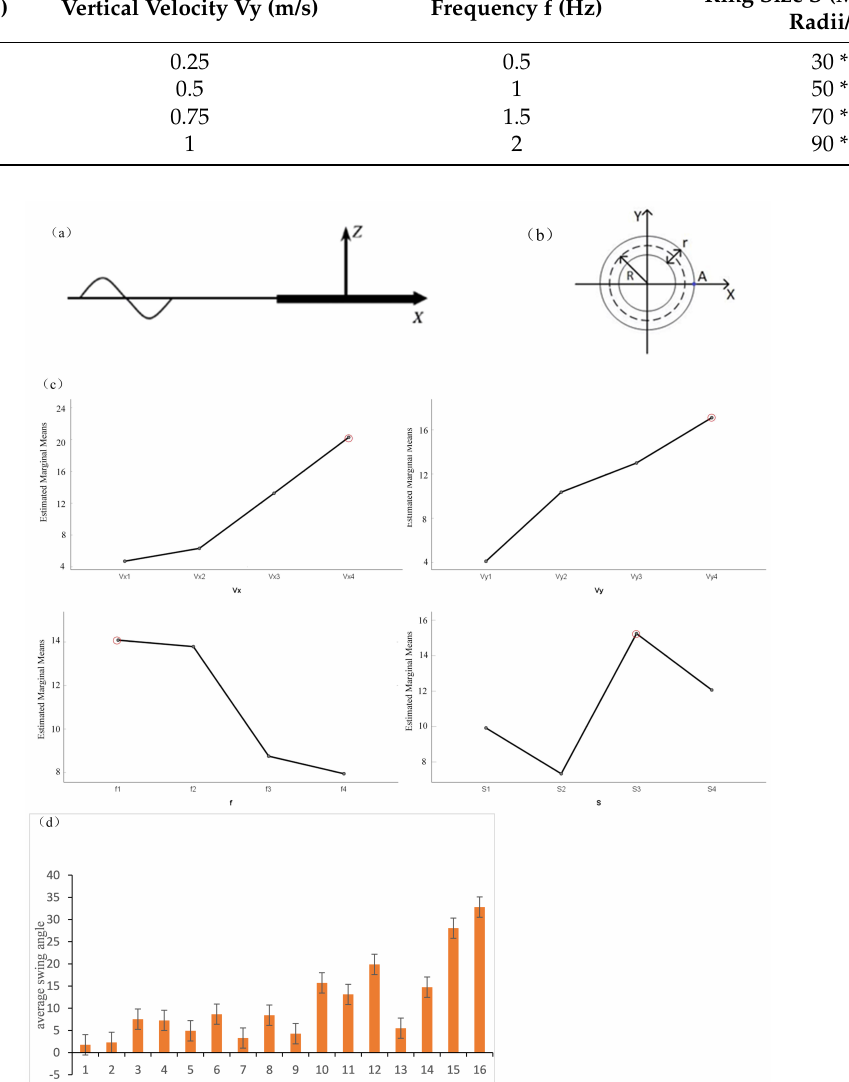
Figure 2. ( a ) The coordinate system of the A-TENG. ( b ) The plane coordinate system of the A-TENG. ( c ) The contour plot of the estimated marginal mean value of the annular swing angle corresponding to different levels of the four variables. ( d ) The error bar of the swing angle plot (standard